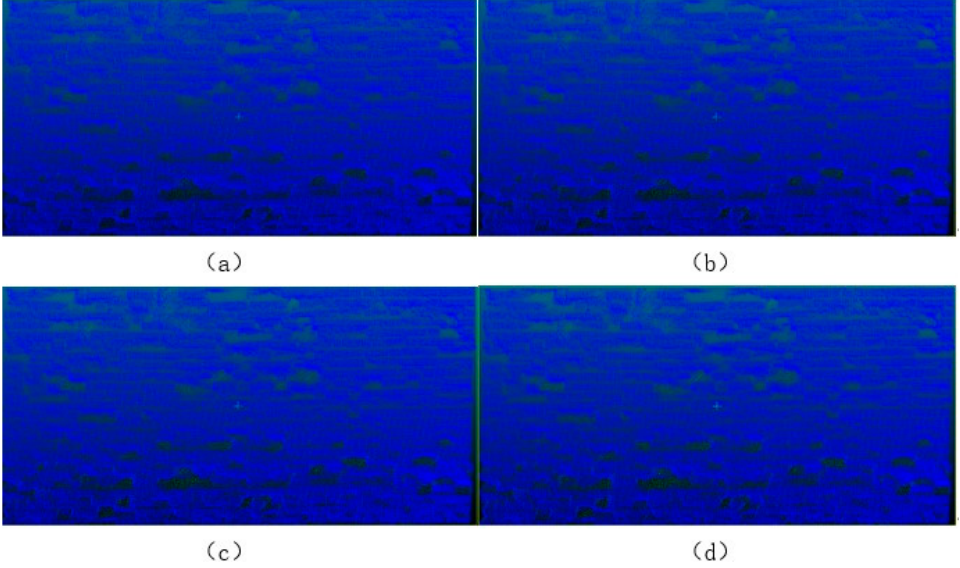
Figure 21. Point cloud marked by Structure Tensor “Eigenentropy”. ( a ) K = 4. ( b ) K = 6. ( c ) K = 8. ( d ) K = 10.